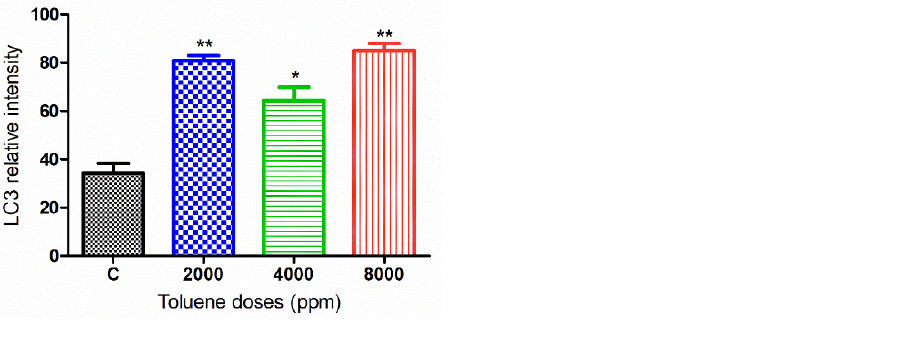
Figure 8. Relative fluorescence intensity of LC-3 levels in the control and exposed groups. Values are